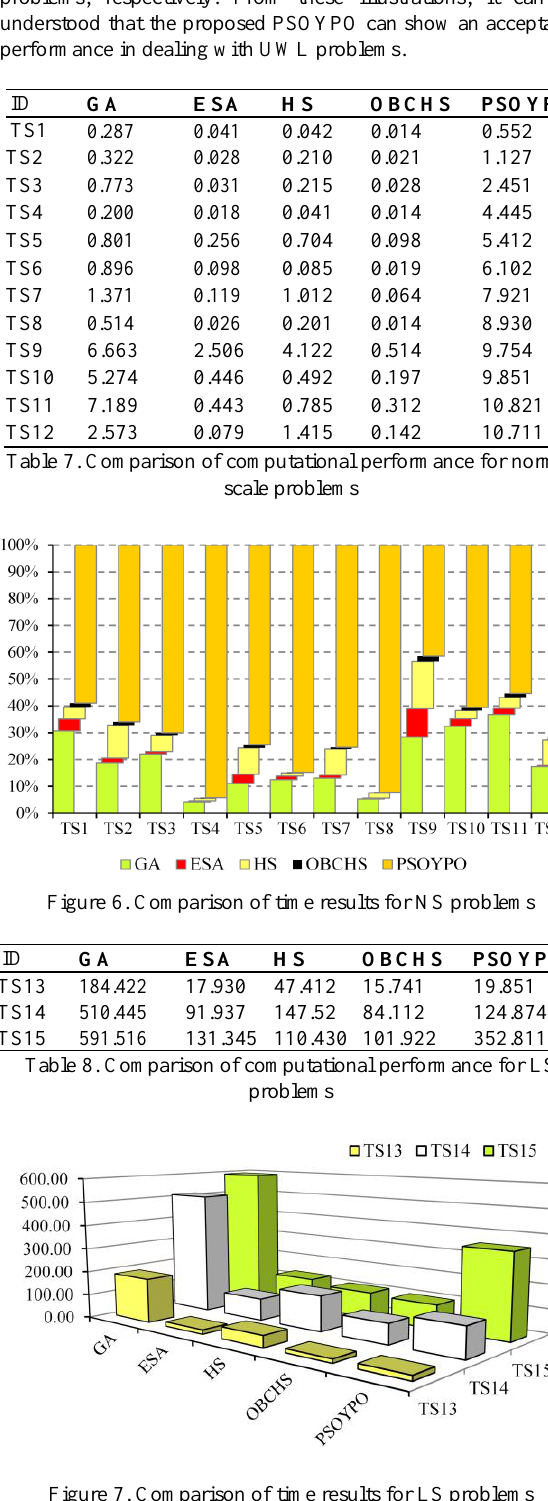
Figure 7. Comparison of time results for LS problems